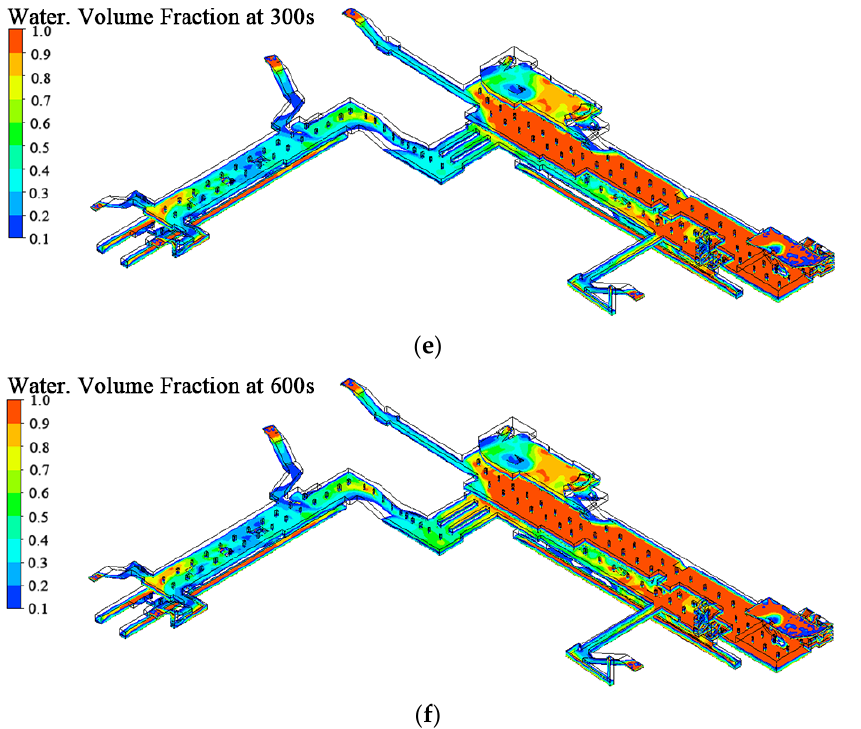
Figure 9. Flood inundated area of the subway station. ( a ) Contour of water volume fraction at 10 s, ( b ) contour of water volume fraction at 30 s, ( c ) contour of water volume fraction at 60 s, ( d ) contour of water volume fraction at 120 s, ( e ) contour of water volume fraction at 300 s, ( f ) contour of water volume fraction at 600 s.